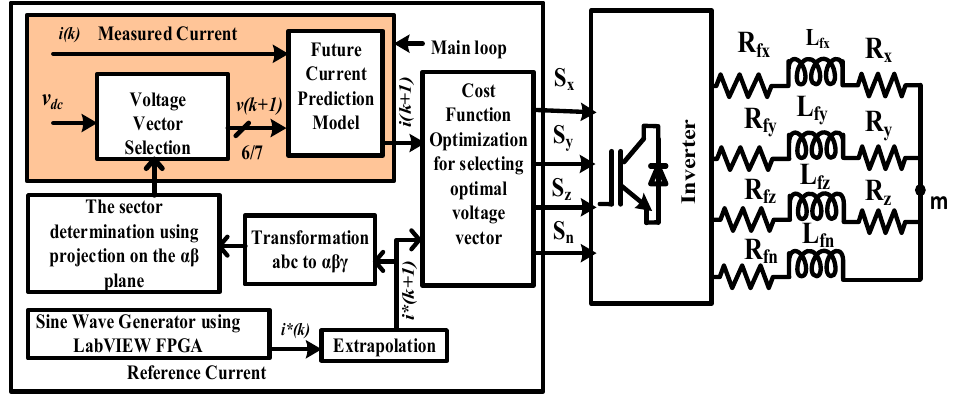
Figure 3. Proposed near state vector selection-based model predictive control (NSV-MPC) block diagram. Table 3. Corresponding common mode voltage (CMV) based on the near state vector (NSV) of each sector.